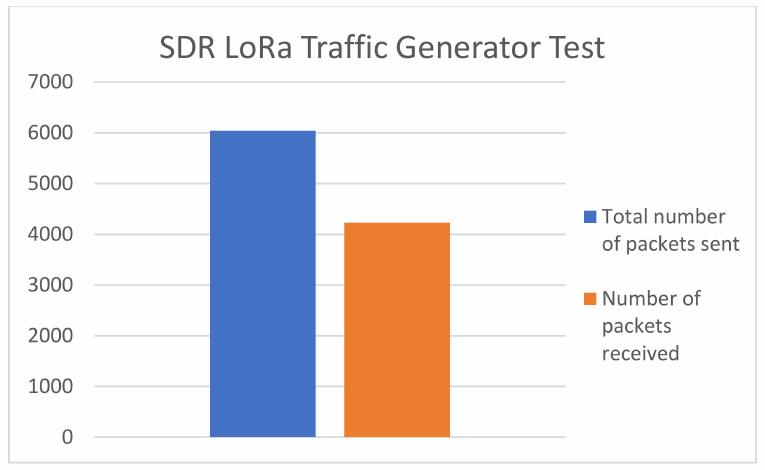
Figure 14. LoRa tra ffi c generator